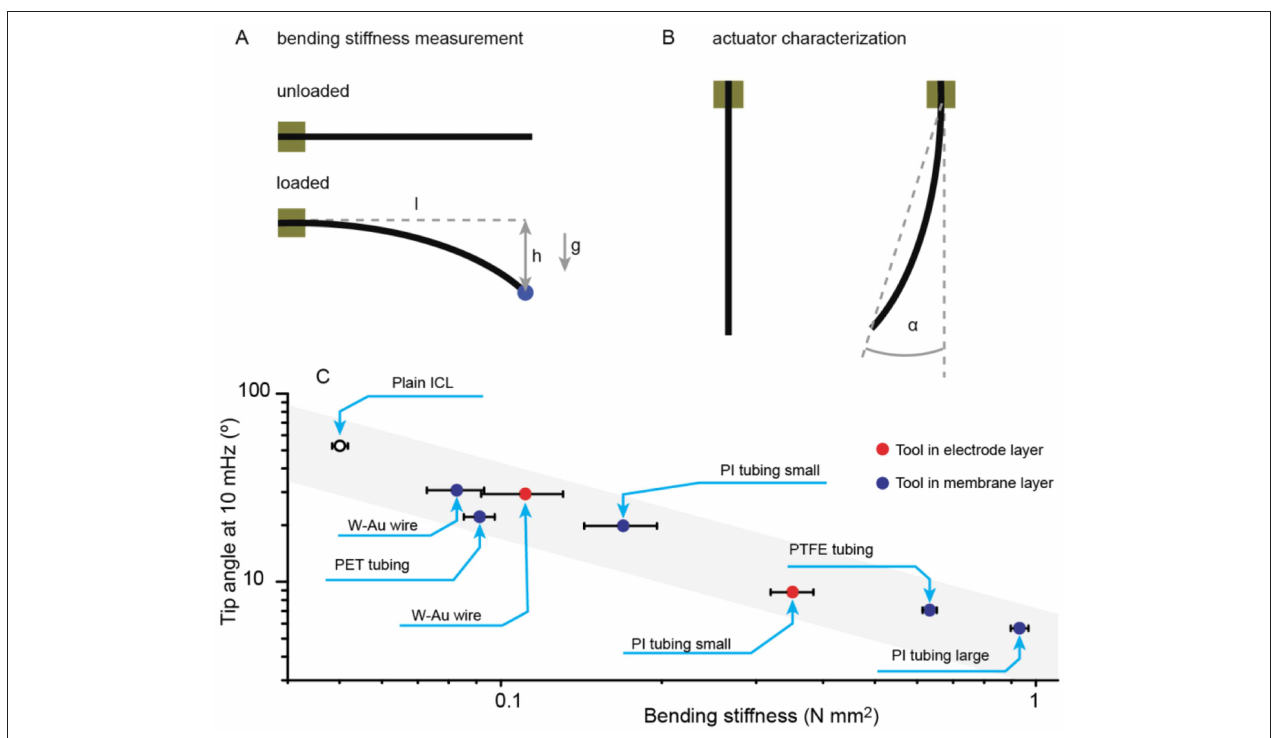
FIGURE 6 | (A) bending stiffness measurement setup; (B) bending angle definition; (C) Manipulator deflection with ± 2V 10 mHz triangular input signal for ICLs carrying denoted tools vs. their bending stiffness.